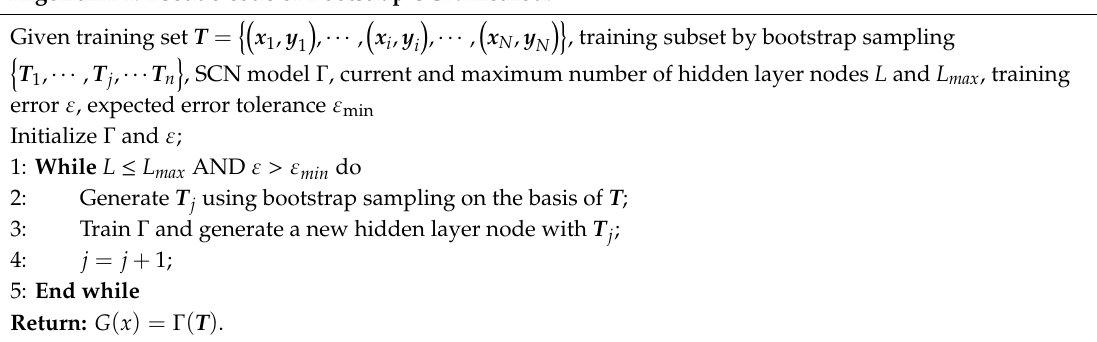
Algorithm 1: Pseudo code of Bootstrap-SCN method.